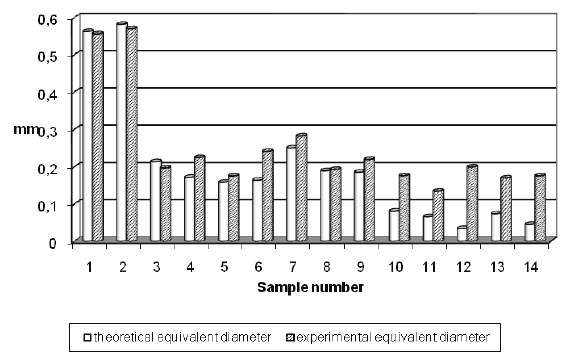
Fig. 6: the experimental values are higher than the theo- retical ones. The assessment of the influence of the shape of the pores on the flow through the woven sample will be done via CFD simulation in a future